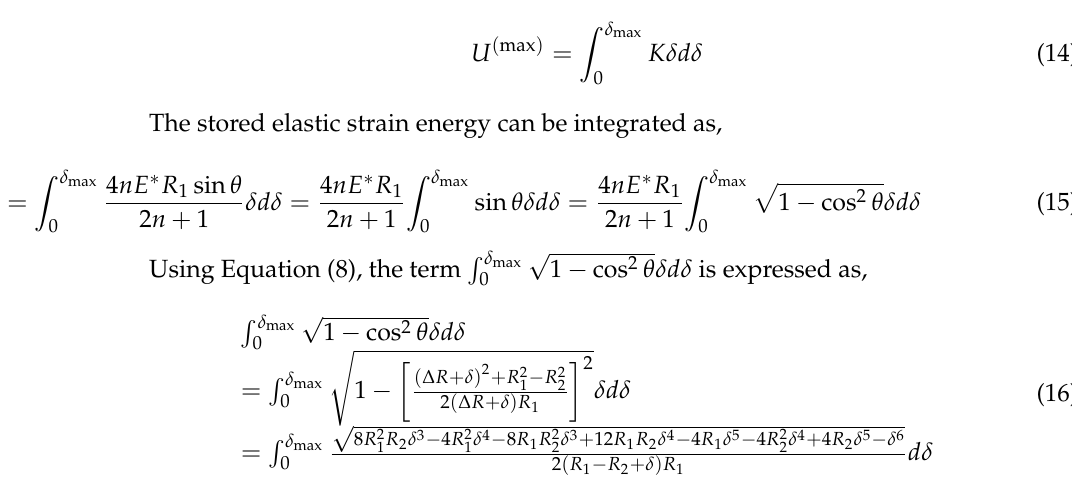
Figure 3. The proposed contact force model is validated by FEM.